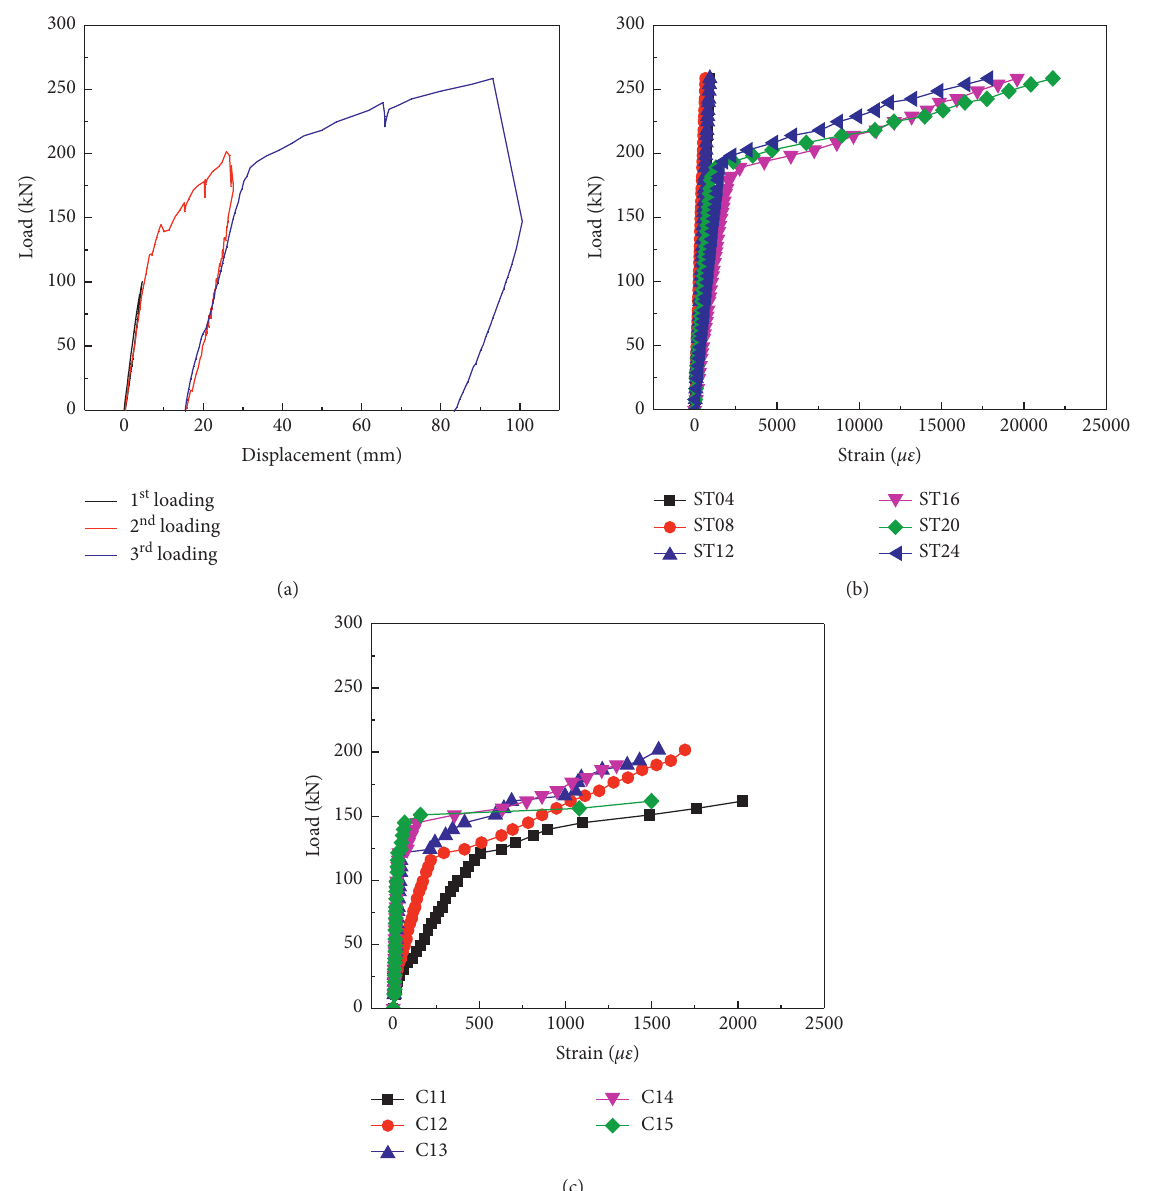
Figure 6: Measured displacement and strain on the structure: (a) measured vertical displacement at the middle span of girder 2; (b) measured steel strain at the 1/4 and 1/2 span locations of girder 1, 2, and 3; (c) measured concrete strain on the bottom surface at the 1/2 span